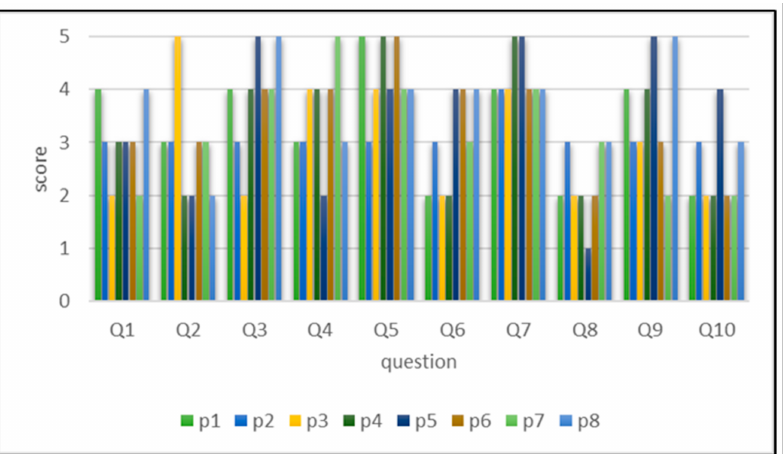
Figure 15. Statistical results of the System Usability